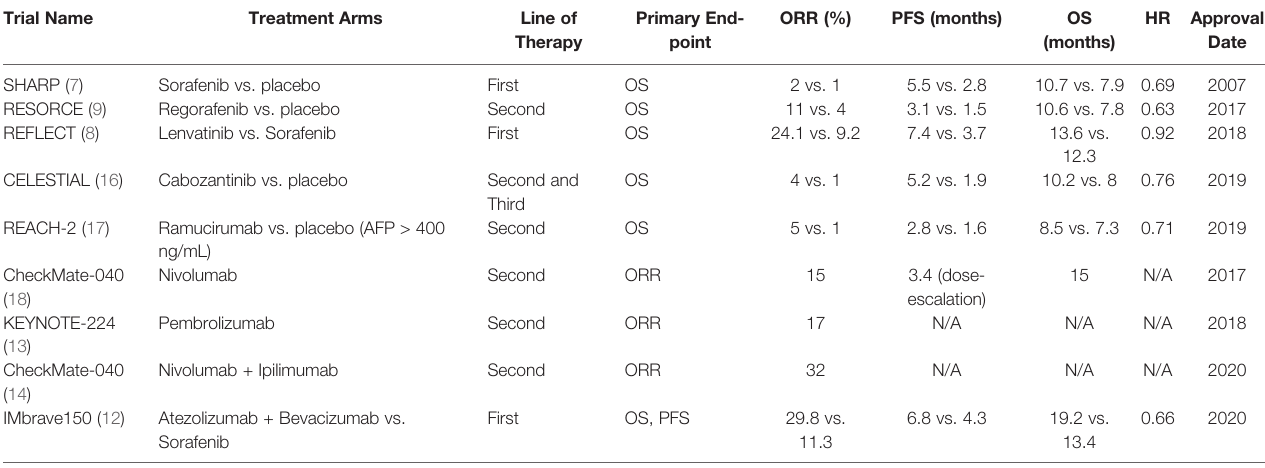
TABLE 1 | Key fi ndings of landmark clinical trials for the approved systemic therapies in advanced